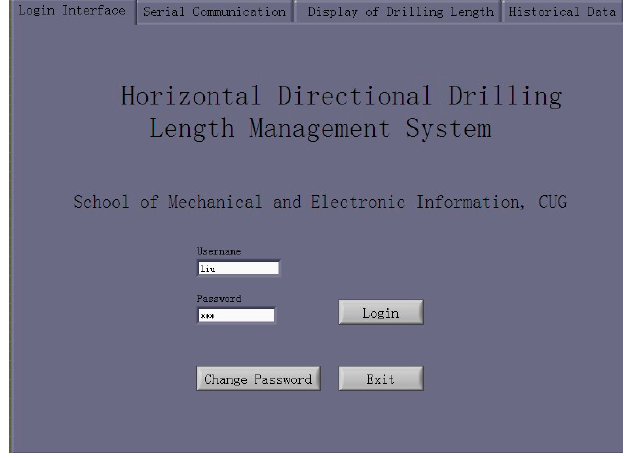
Figure 8. Login interface.